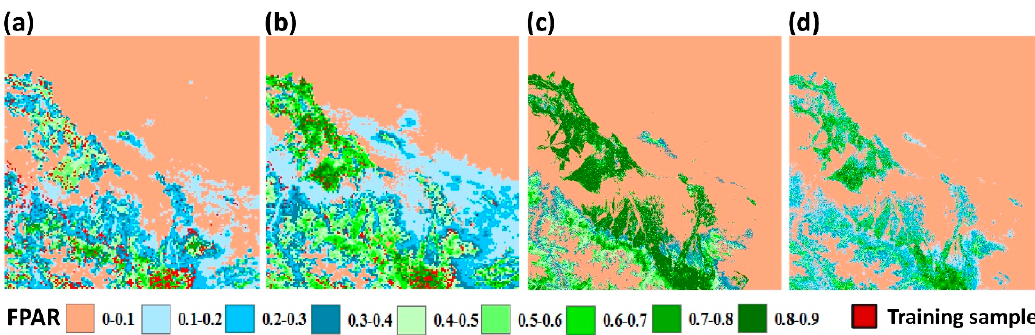
Figure 4. Multi-scale maps of FPAR in July 2012: ( a ) global LAnd Surface Satellite (GLASS) FPAR (1 km); ( b ) MODerate Resolution Imaging Spectroradiometer (MODIS) FPAR (1 km); ( c ) D_FPAR_GLASS (30 m); ( d ) D_FPAR_MODIS (30 m). The red pixels are the training samples.